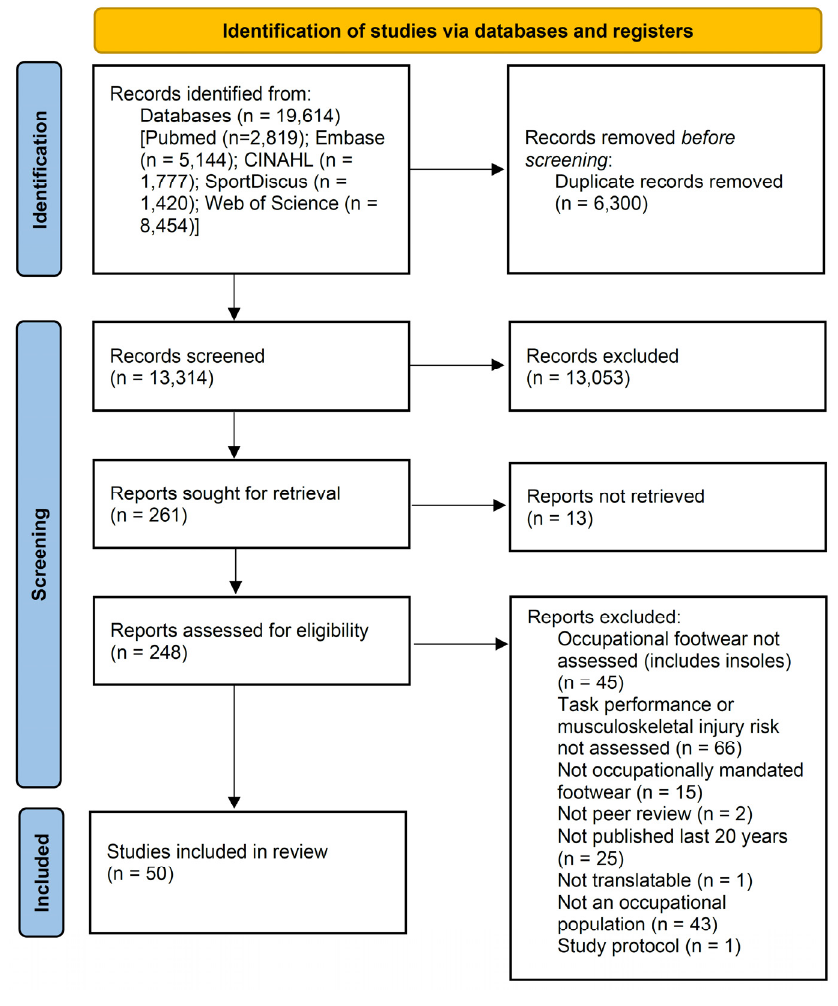
Figure 1. PRISMA Flow diagram showing results of the search, screening, and selection process [26]. The included articles represented work from 16 countries, with nine population